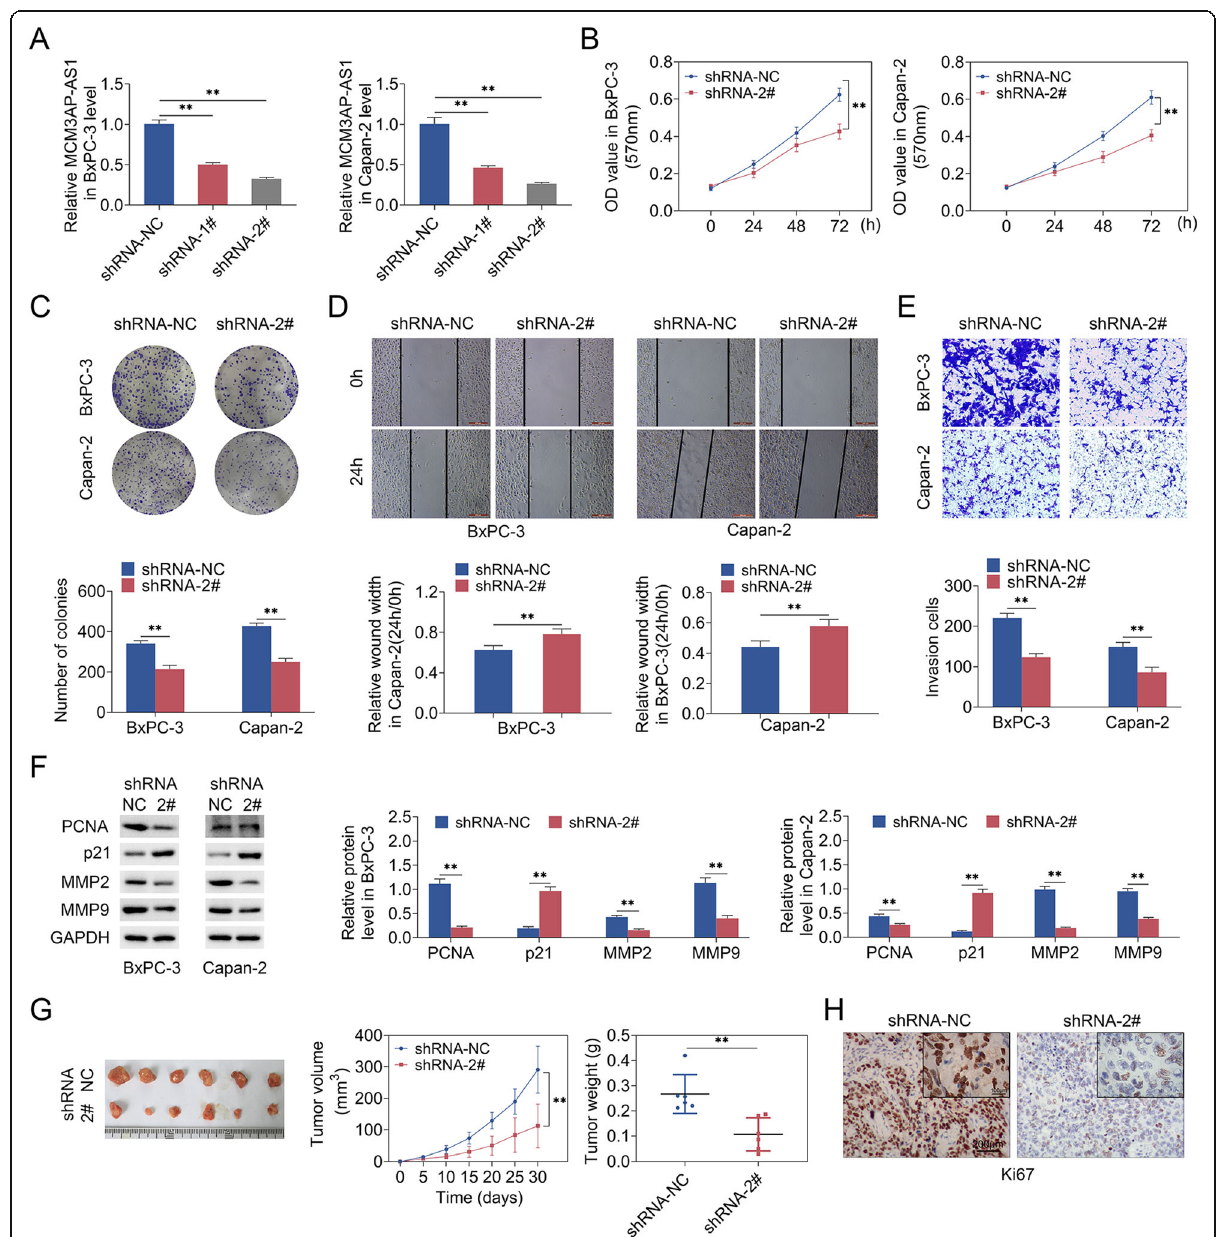
Fig. 3 MCM3AP-AS1 knockdown inhibited cell growth and invasion in PC cells, and suppressed tumor growth in mice. a qRT-PCR was used to measure MCM3AP-AS1 level. b Cell proliferation was detected using MTT assay. c Clone formation assay was used to measure clone formation ability. d - e Cell invasion and migration was examined by Transwell assay and wound healing assay. Scale bar: 50 μ m. f Western blot analysis detected PCNA, MMP2, MMP9 and p21 protein levels. n = 3. g Tumor volume and weight were examined. h Immunohistochemical staining testified Ki67 expression. Scale bar: 50 μ m. (**, p <